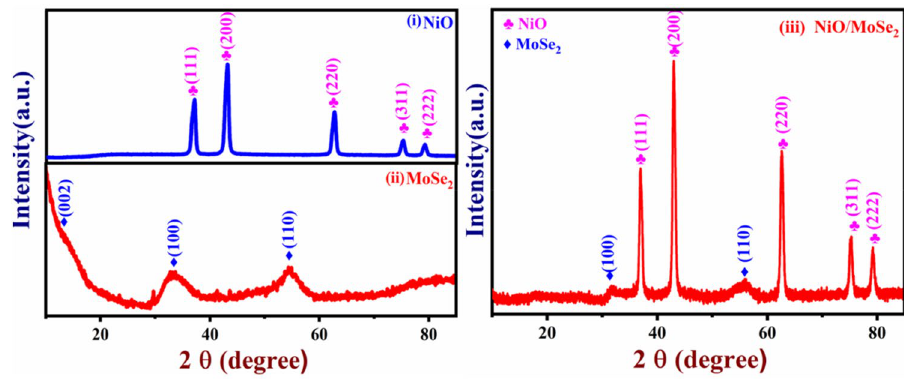
Figure 1. PXRD spectra of the (i) NiO, (ii) MoSe 2 powder and (iii) NiO/MoSe 2